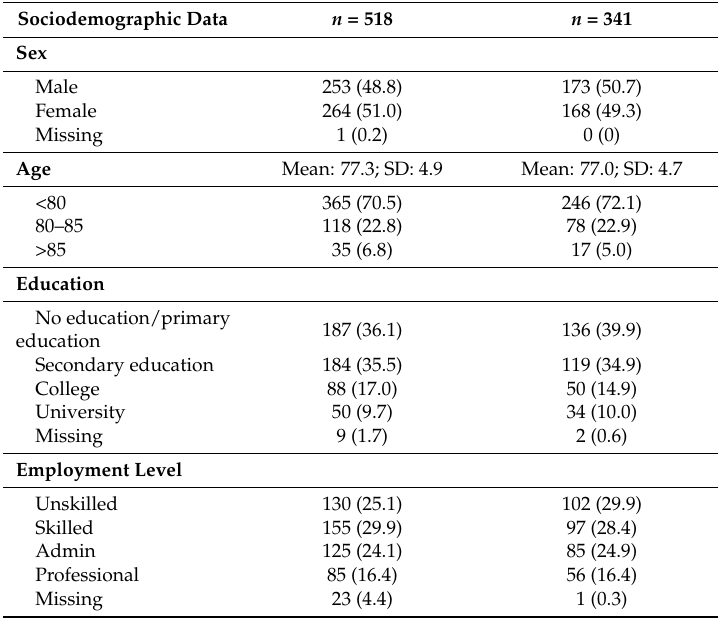
Table 1. Sociodemographic data ( n = 518; n = 341 complete data sets included in regression analyses) All values are number (%) unless stated